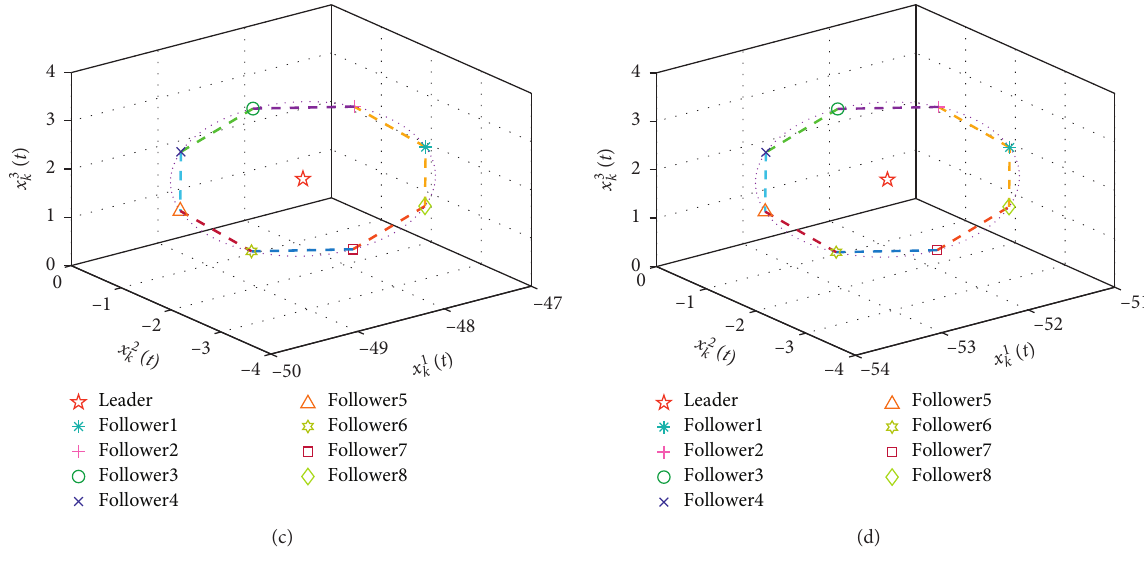
Figure 8: State snapshots of all the agents at different time for time-invariant formation tracking case: (a) t � 0 s, (b) t � 12s, (c) t � 13 s, and (d) t � 14s.